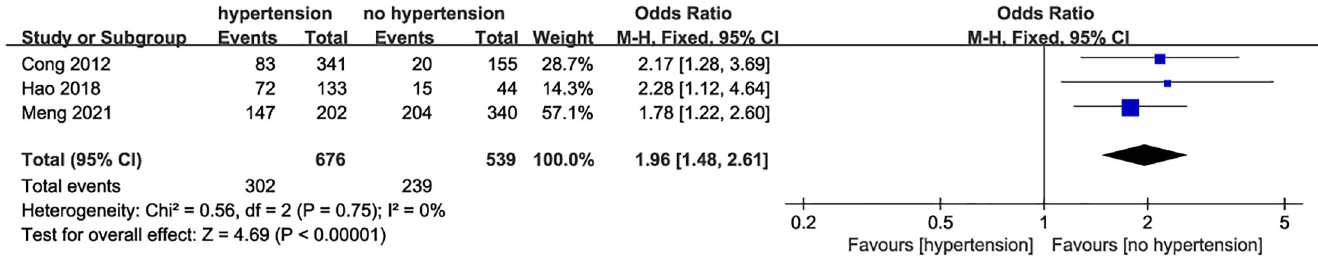
Fig 4. Forest plot for the relationship between hypertension and dysphagia after stroke.